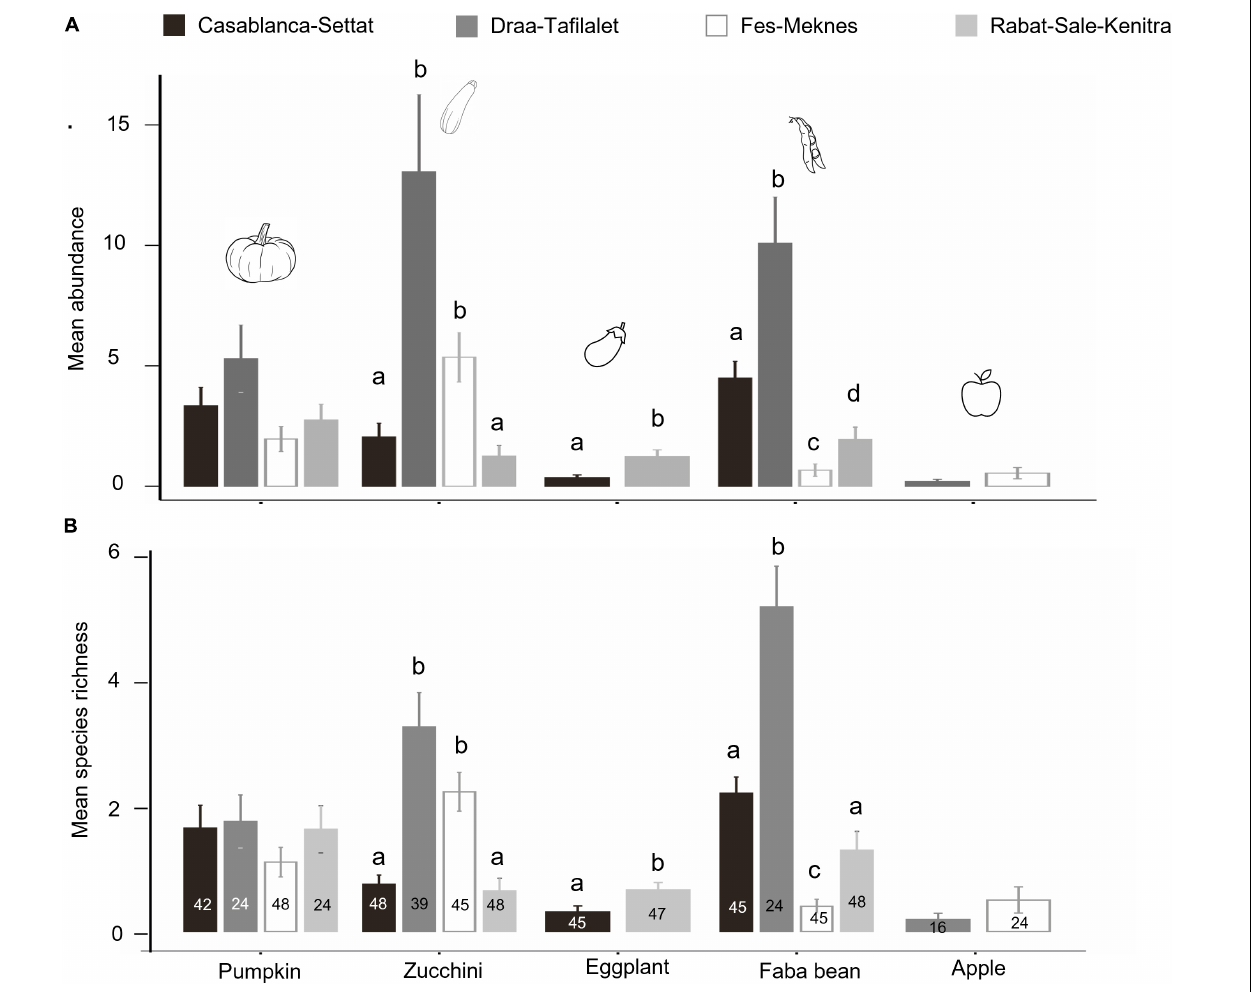
FIGURE 4 | (A) Mean number of bee individuals visiting each crop in the areas where the crop was surveyed. (B) Mean number of bee species visiting each crop in the areas where the crop was surveyed. Means ± SE are shown. Small letters indicate significant differences between regions for each crop present in more than one region. Numbers indicate the number of observations (combination of year/field/sampling).